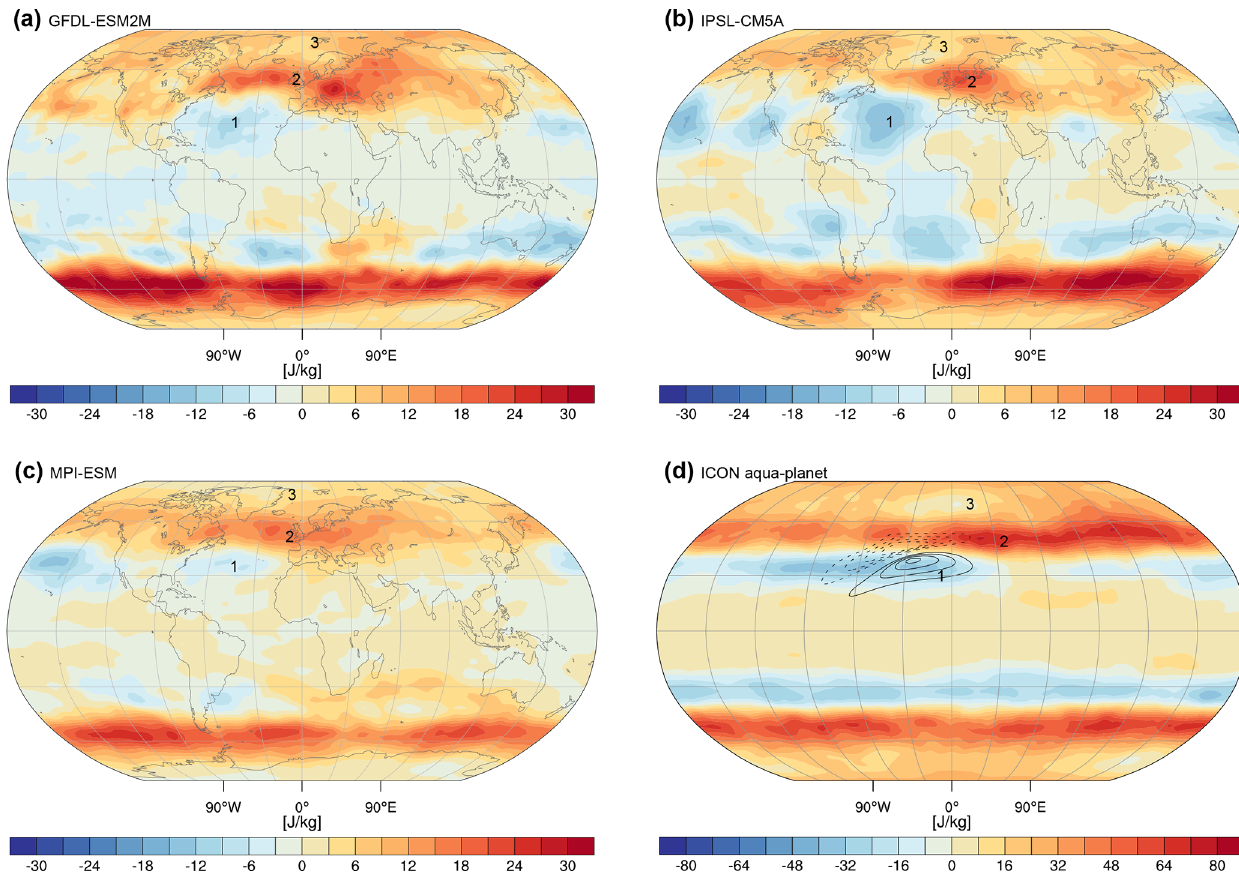
Figure 2. Eddy kinetic energy difference (shading; Jkg − 1 ) at the 250hPa level between the periods 2091–2100 and 2011–2030 (December– February) for the RCP8.5 scenario and for the (a) GFDL-ESM2M, (b) IPSL-CM5A LR, (c) MPI-ESM LR, and (d) idealized ICON aqua- planet simulation including a SST front in the Northern Hemisphere, which is warmed by